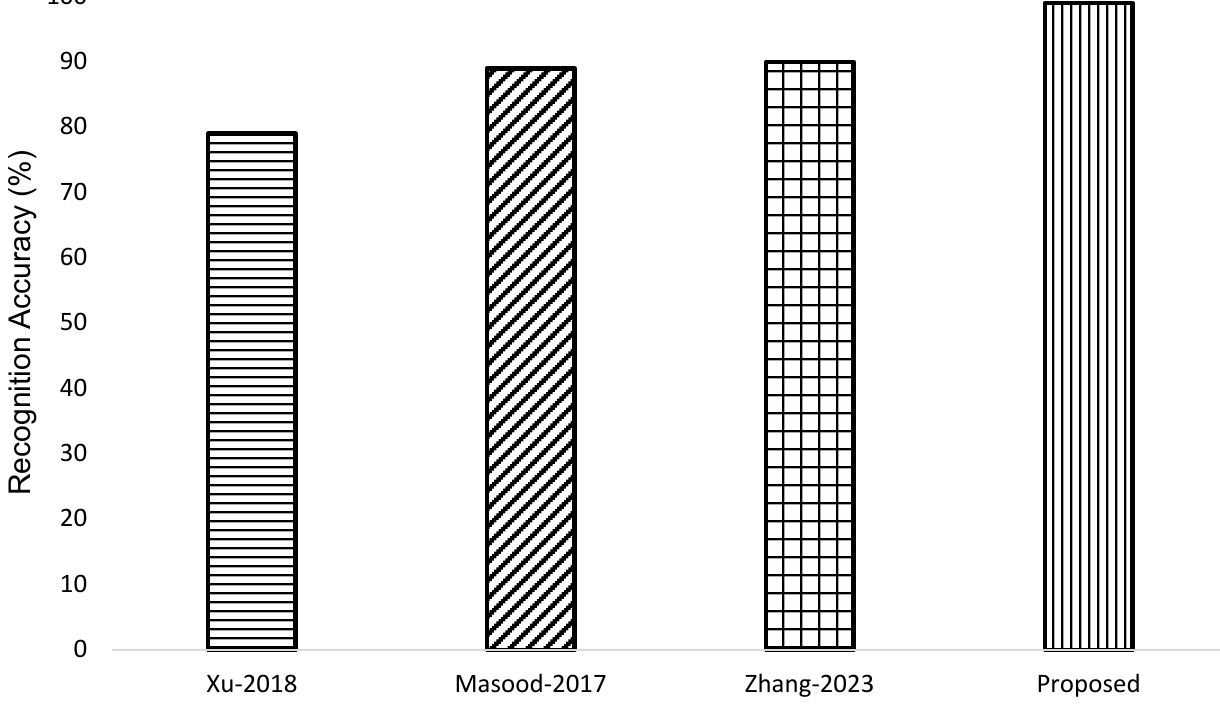
Figure 5 . Mean LP recognition comparison on the PKU dataset. Figure 5. Mean LP recognition comparison on the PKU